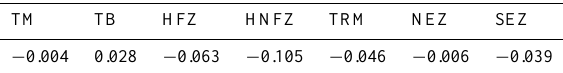
Fig. 5. Fraction of precipitation amount due to very wet days (R95pTOT) for the Crkvice station for the period 1951-2007. Dashed line indicates Sen’s estimator of the slope.